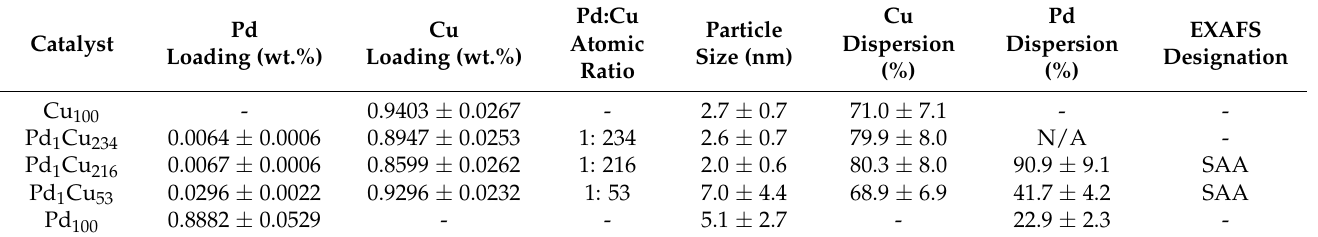
Table 1. Summary of the characterisation data for the supported catalysts